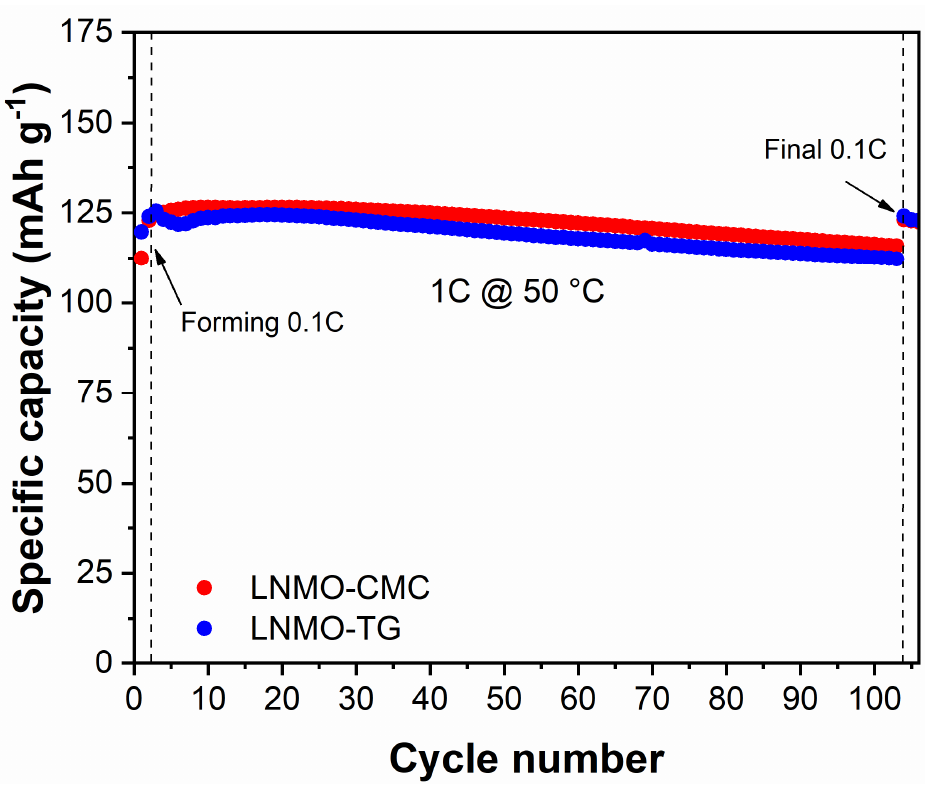
Figure 6. Comparison of specific discharge capacity of the LNMO electrode containing TG and CMC, cycled at 0.1 C for 3 cycles and 1 C for further cycles at 50 °C between 3.5 V and 4.9 V.